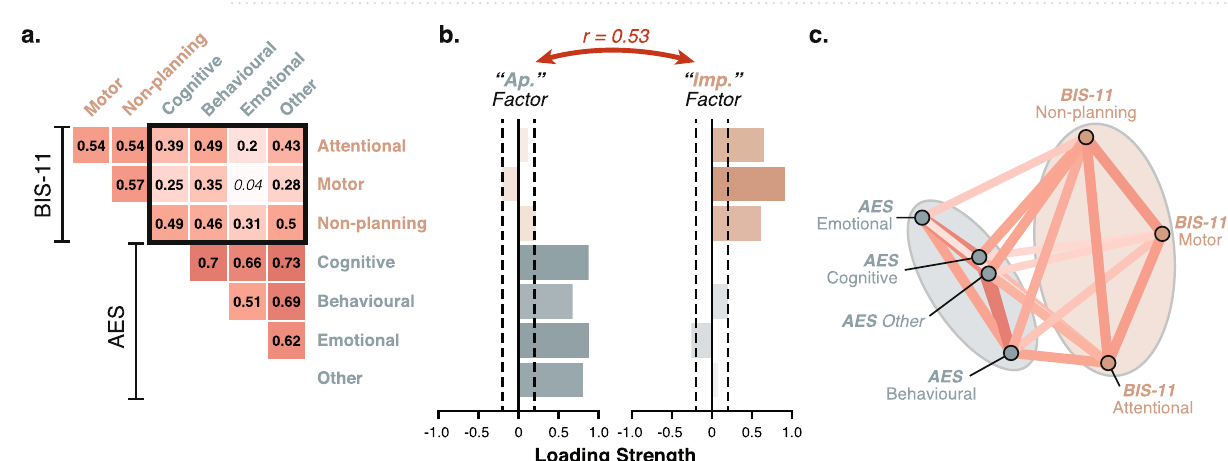
Figure 1. Apathy (AES, AMI) and impulsivity (BIS-11) are positively correlated. ( a ) In all four open datasets 42–45 , a positive correlation was observed between the total score of the AES and BIS-11. In the two datasets including the AMI instead of the AES (Datasets 5–6), a similar, although weaker, relationship was observed. Lighter colours represented higher density. ( b ) Venn diagrams highlighted a large proportion of people who qualified as both apathetic and impulsive according to standard cut-offs (dotted grey lines in panel a; AES total: 40 46 ; BIS-11 total: 72 47 ; AMI total: 2.15 36 ).